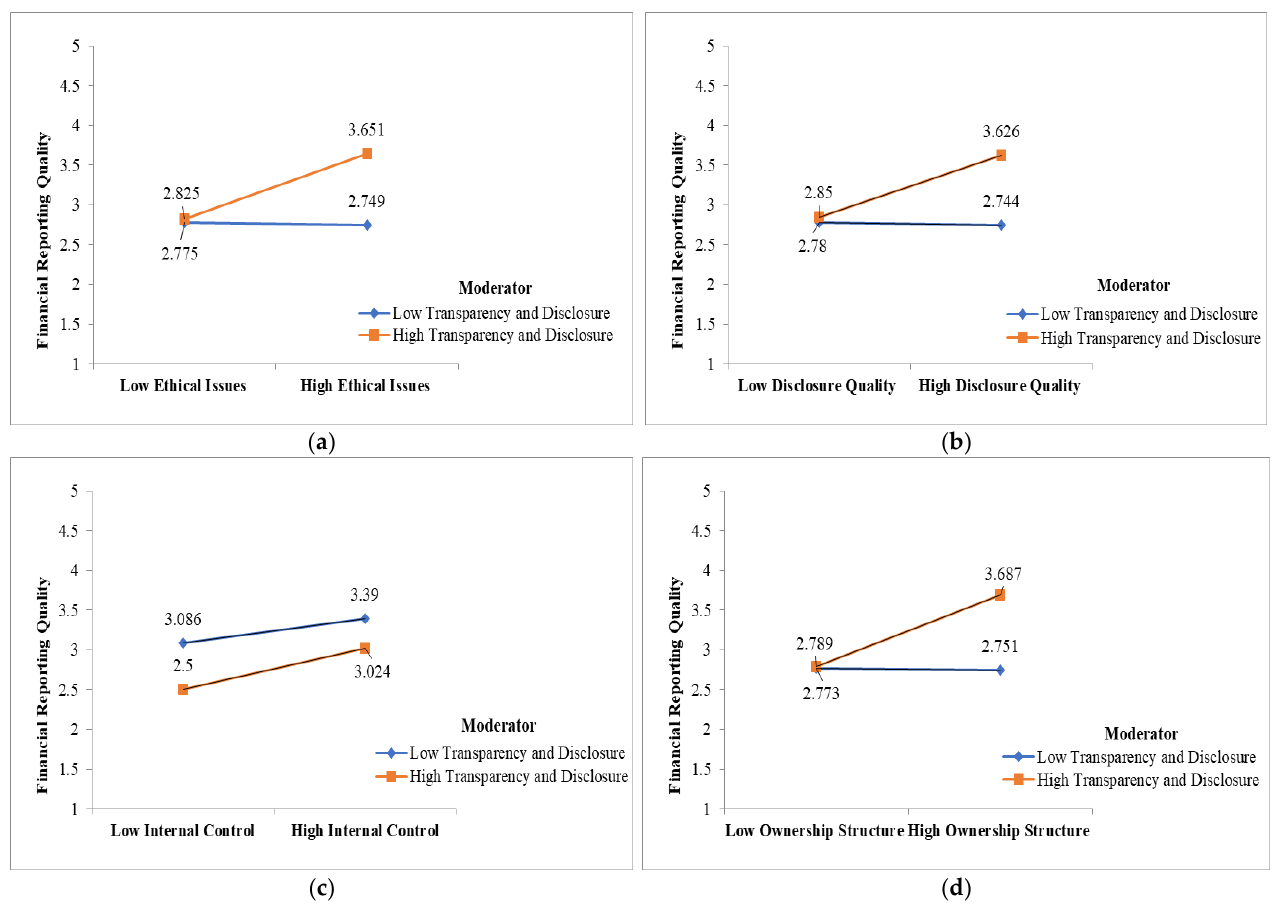
Figure 6. ( a ) A two-way interaction of the TD on the EI and FRQ. ( b ) A two-way interaction of the TD on the DQ and FRQ. ( c ) A two-way interaction of the TD on the IC and FRQ. ( d ) A two-way interaction of the TD on the OS and FRQ.